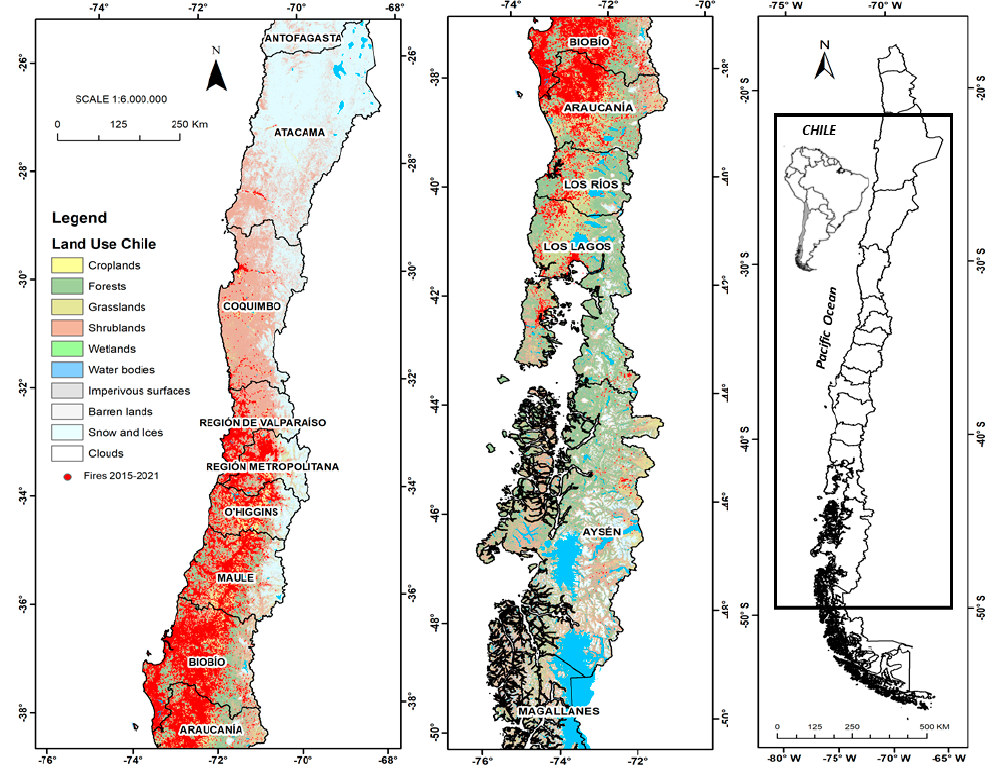
Figure 1. National diagnosis of the occurrence of wildfires in Chile. Period 2015–2021. Areas highlighted in red indicate the distribution and concentration of forest fires in the south-central region of Chile.